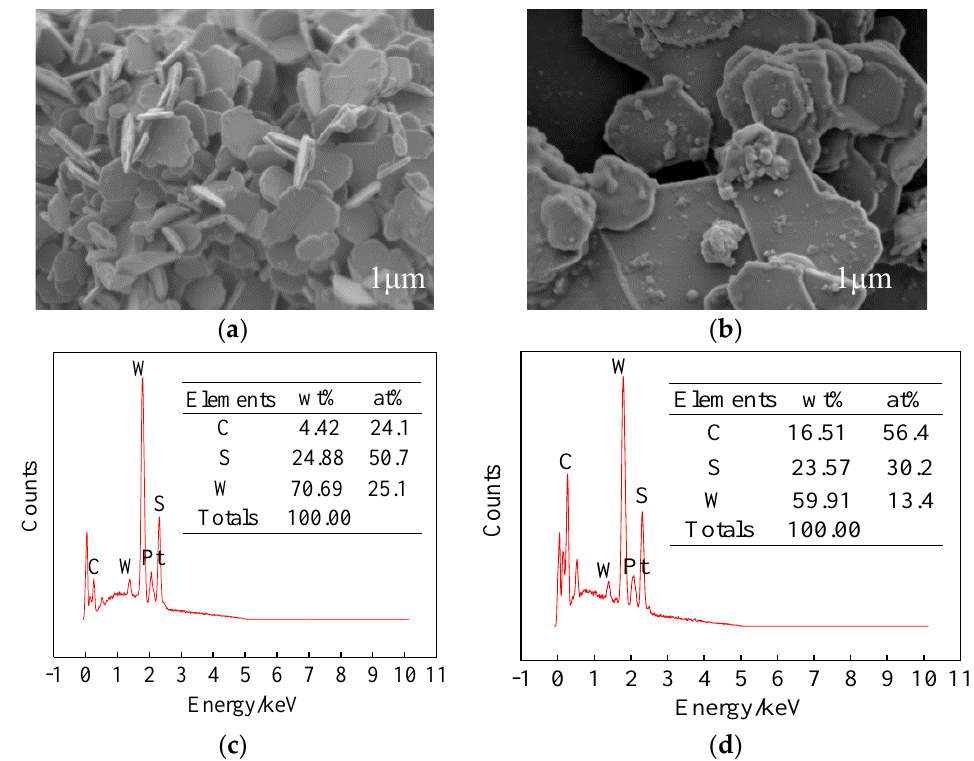
Figure 3. SEM pictures and energy-dispersive spectroscopy (EDS) analyses of ( a , c ) WS 2 , and ( b , d ) WS 2 -C.